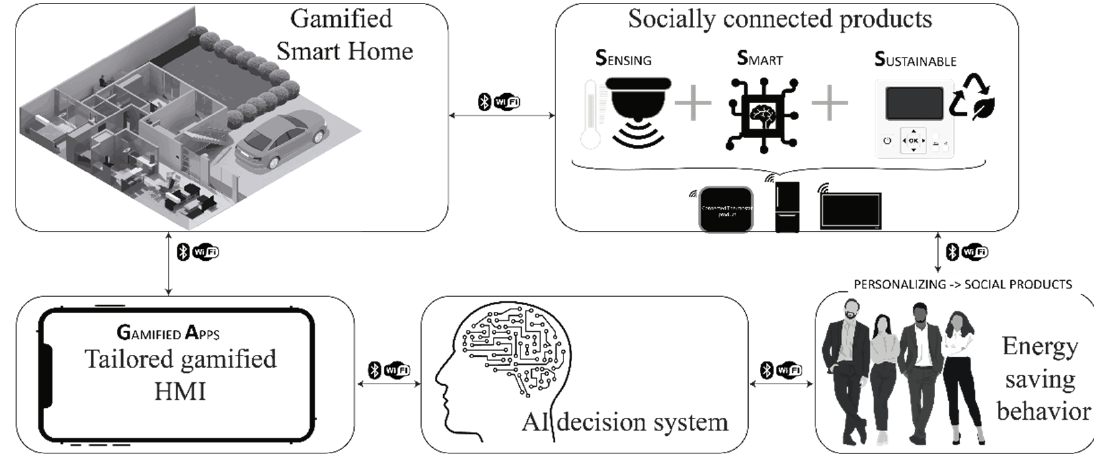
Figure 1. Gamified Smart Home structure.